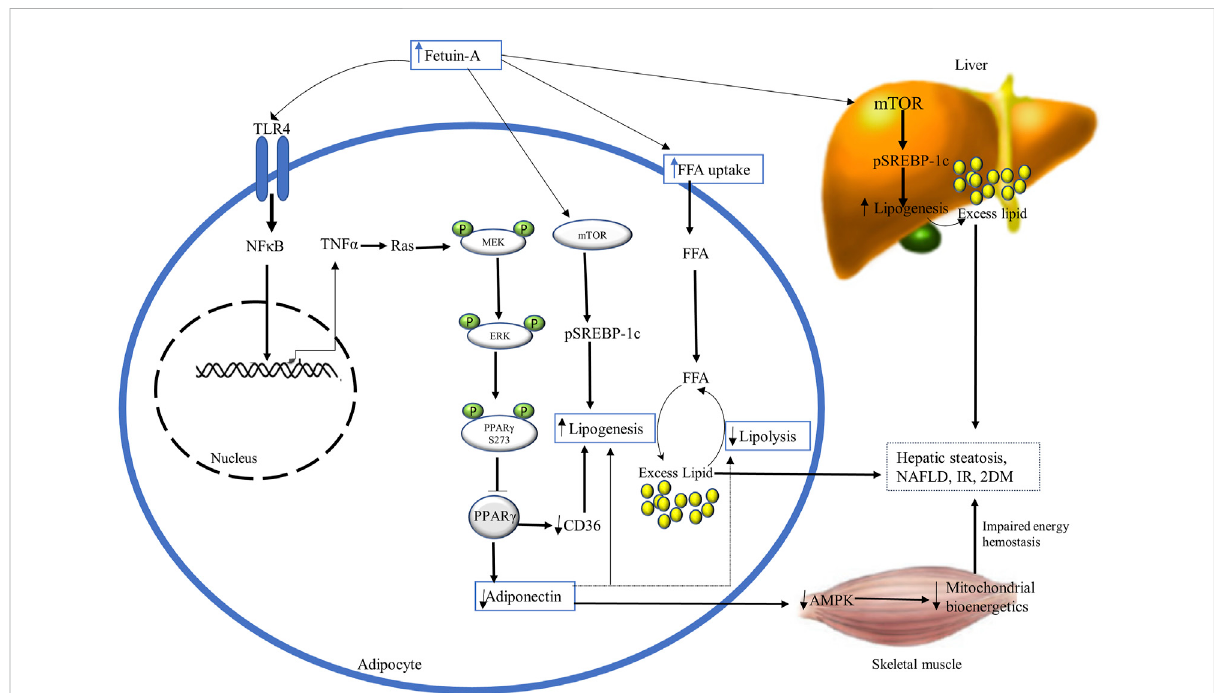
FIGURE 3 The diagrammatic illustration of the adipogenic role of fetuin-A. Excess fetuin-A release (from liver and adipocytes) may increase FFA uptake and accumulation in adipocytes and impair their function by inhibiting PPAR γ and stimulating mTOR. Fetuin-A-mediated inhibition of PPAR γ occurs through phosphorylation at serine 273 by TLR4-induced activation of NF κ B-TNF α -Ras-MEK-ERK cascading. This suppression of PPARy lowers adiponectin levels and antagonizes its insulin-sensitizing and anti-in fl ammatory actions by impairing AMPK and mitochondrial bioenergetics. Besides, inhibition of PPARy downregulates the expression of CD36, resulting in lipogenesis and excess fat accumulations in adipocytes, disrupting insulin sensitivity. Excess fetuin-A also plays builds up excess fat in the liver and adipocytes by the stimulatory phosphorylation of mTOR that enhances the expression of SREBP-1c inducing lipogenesis. Ultimately, fetuin-A-induced disruption of mitochondrial bioenergetics and increased lipogenesis results in hepatic steatosis, NAFLD, IR, and T2DM. Abbreviations: AMPK, AMP-activated kinase; mTOR, phosphorylation of mammalian target of rapamycin; NF κ B, nuclear factor κ B; PPARy, Peroxisome proliferator-activated receptor-gamma; SREBP-1c, steroid regulatory element- binding protein-1c; TNF- α , tumor necrosis